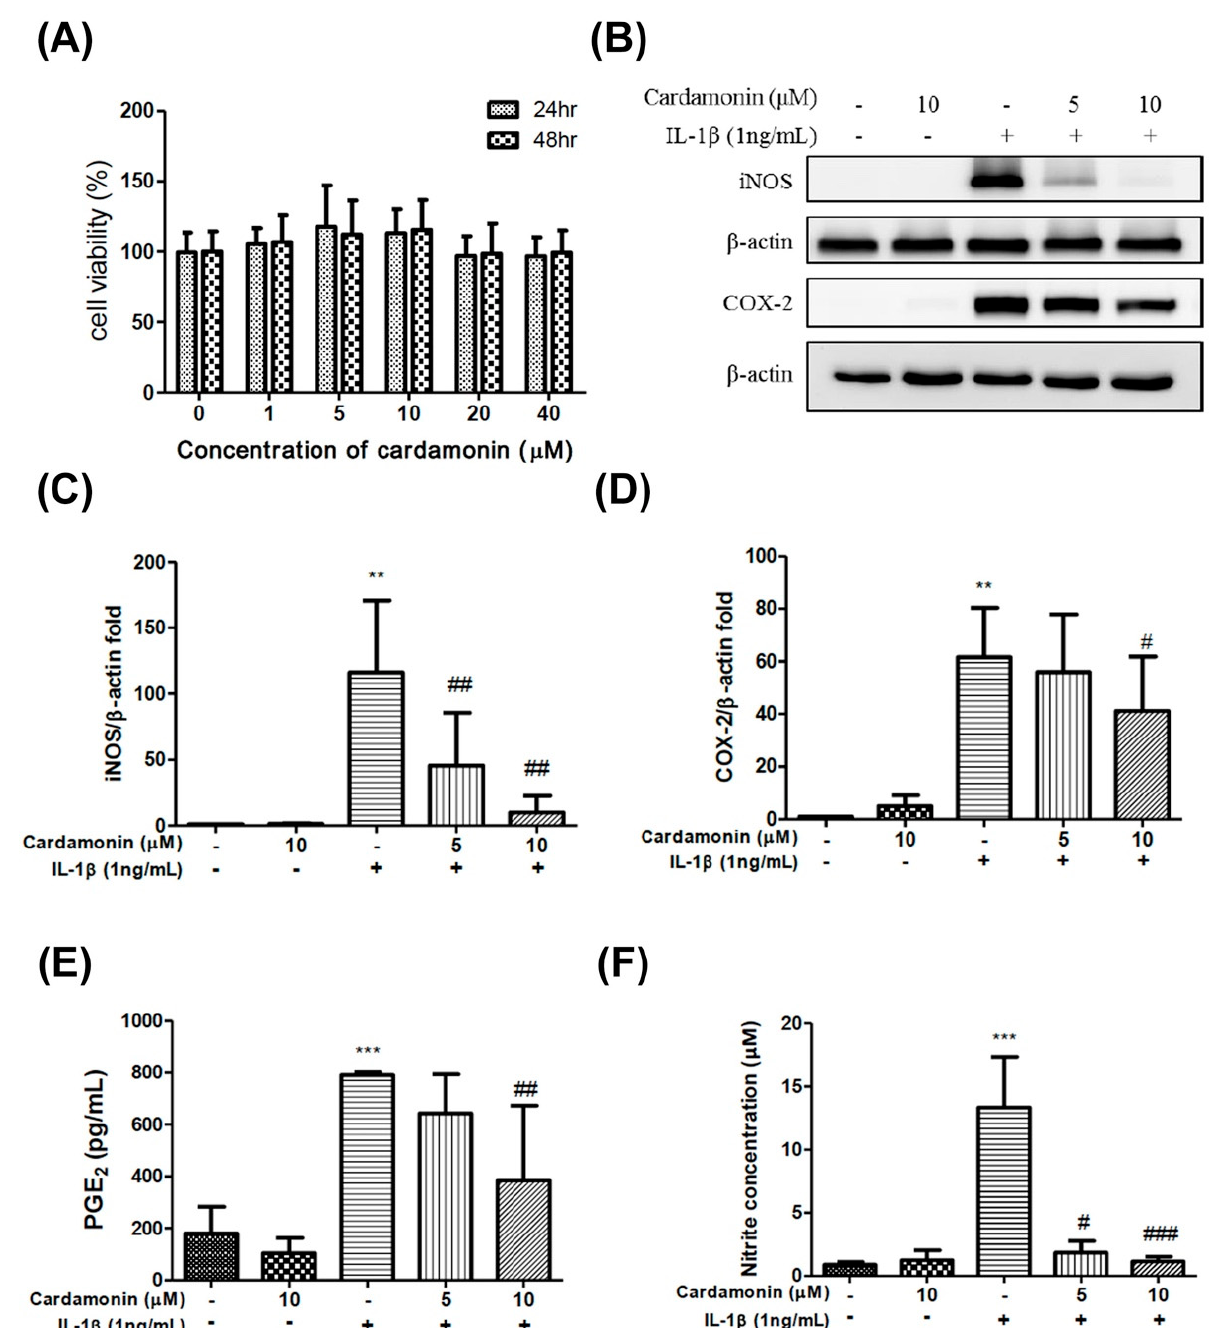
Figure 1. Cardamonin suppressed IL-1 β -induced iNOS and COX2 expression and prevented the IL-1 β -mediated induction of PGE2 and the IL-1 β -mediated production of nitric oxide in human OA chondrocytes. ( A ) MTT assays were used to examine the cytotoxicity of cardamonin on human chondrocytes incubated with 0, 1, 5, 10, 20, and 40 µ M/mL of cardamonin for 24 or 48 h. ( B – D ) At a concentration of 10 µ M, cardamonin was shown to significantly reduce iNOS and COX-2 protein expression levels in chondrocytes stimulated with IL-1 β for 24 h. ( E , F ) PGE2 and nitric oxide concentrations were significantly increased following treatment with IL-1 β for 24 h; however, these increases were significantly decreased following treatment with 10 µ M cardamonin. All data comes from at least three independent experiments, and their significance were as follows: cardamonin group and the control group are indicated by an asterisk (*); cardamonin group and the IL-1 β group are indicated by a hash symbol (#). # p < 0.05; **, ## p < 0.01; *** p < 0.001.